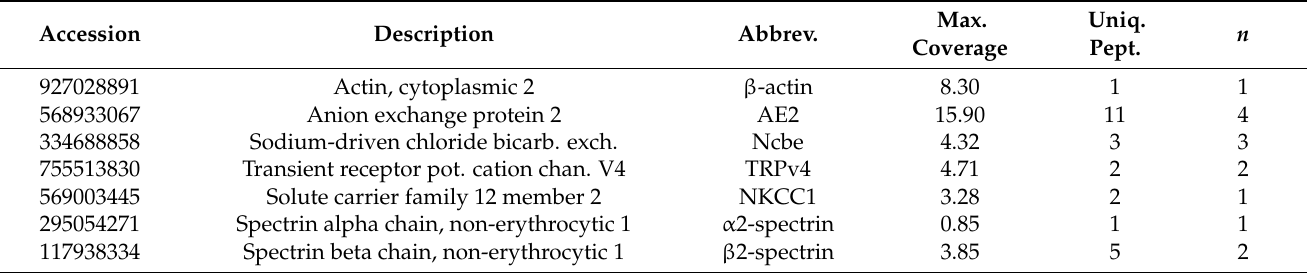
Table 5. Coomassie band located above the NKCC1, AE2, Ncbe immunoreactive band on native PAGE blot. Maximum sequence coverage (Max. Coverage), Unique peptides (Uniq. Pept.), number of identifications (of five replicates, n ).